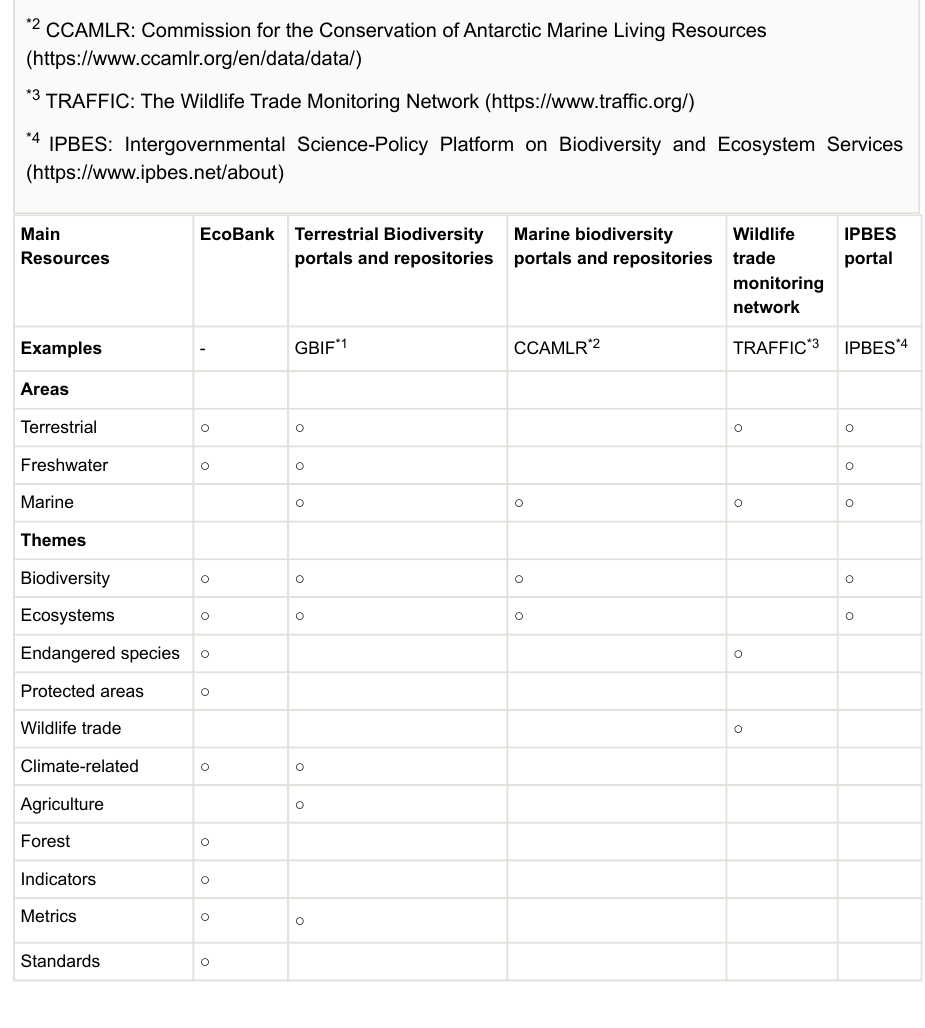
(Table 1). In the project description section, EcoBank’s developmental phases, core technologies and the conceptual design of EcoBank is described and functions related to exchanging, sharing and analysing spatial data through the internet are discussed. The following implementation section describes functions and services, mainly for target stakeholders. This paper ends with the main conclusions and an outlook for future directions. Table 1. Comparison of EcoBank with diverse other repositories from around the world. EcoBank does not contain datasets on marine biodiversity and does not cover wildlife trades and agricultural information. Except for those, however, EcoBank eventually provides all ecological datasets on terrestrial and freshwater systems in